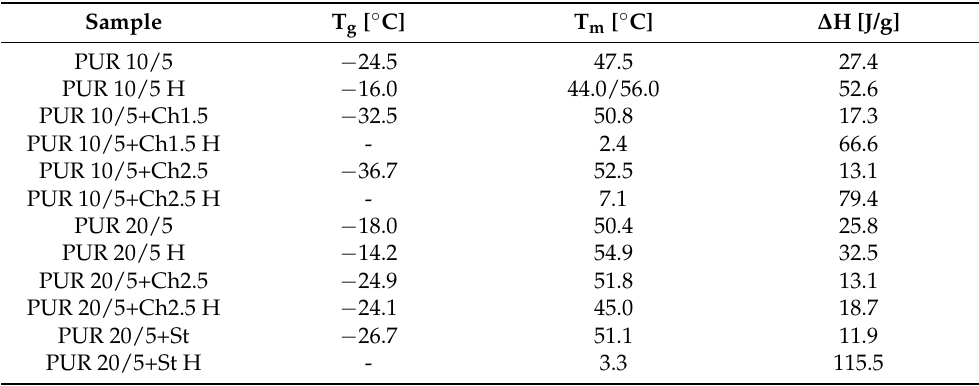
Table 5. Thermal properties of PURs and their blends with polysaccharides before and after incuba- tion in the buffer solution.